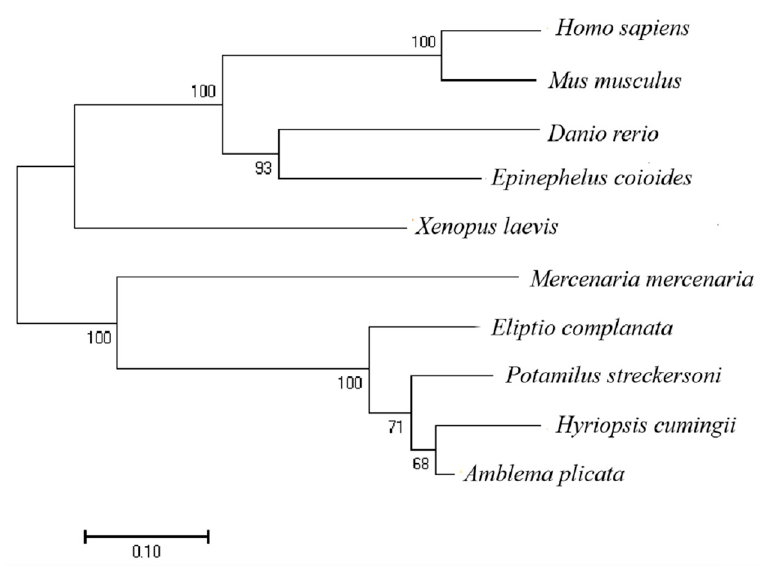
Figure 4. Phylogenetic analysis of IGF1 protein from different species. GenBank accession numbers are as in Figure 3, the number on the node indicates the confidence value of the test for 1000 bootstrap repetitions.